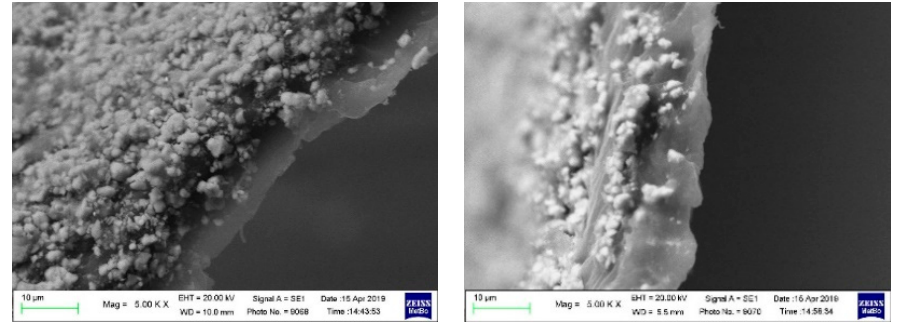
Figure 4. SEM images of the cross-section of the pressed electrode / CN01 separator assembly.